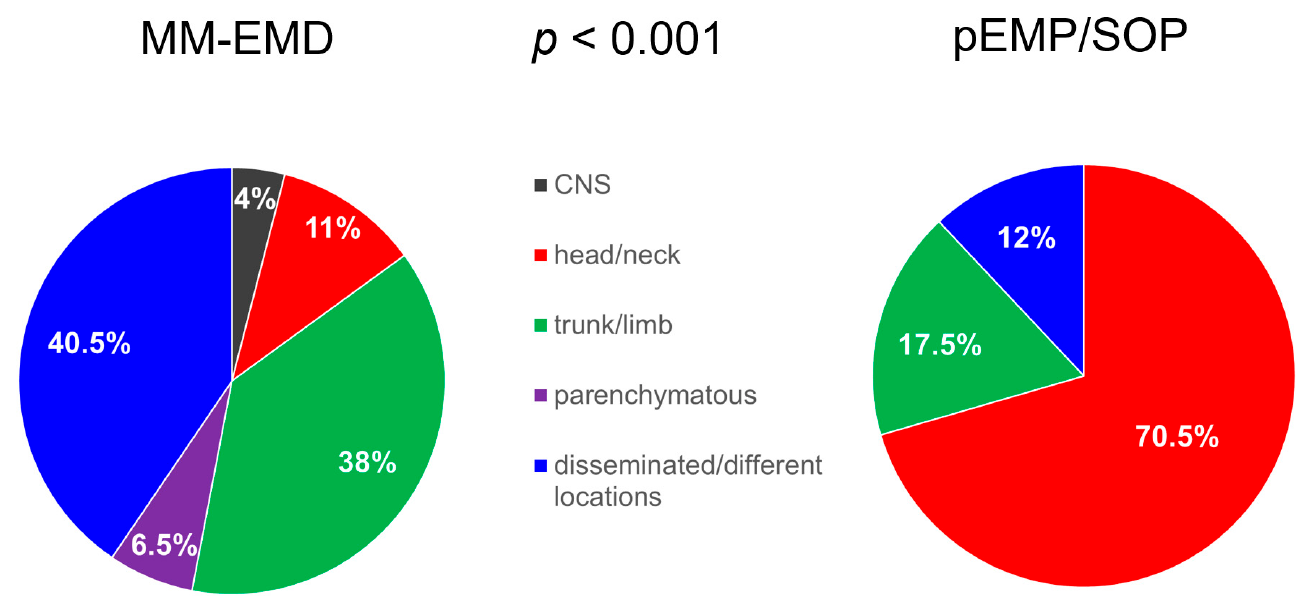
Figure 1. Distribution of locations of MM-EMD ( n = 49) vs. pEMP/SOP ( n = 20). Shown are percentages of patients. MM-EMD multiple myeloma with extramedullary disease; pEMP/SOP primary extramedullary plasmocytoma/solitary osseous plasmocytoma; CNS central nervous system.